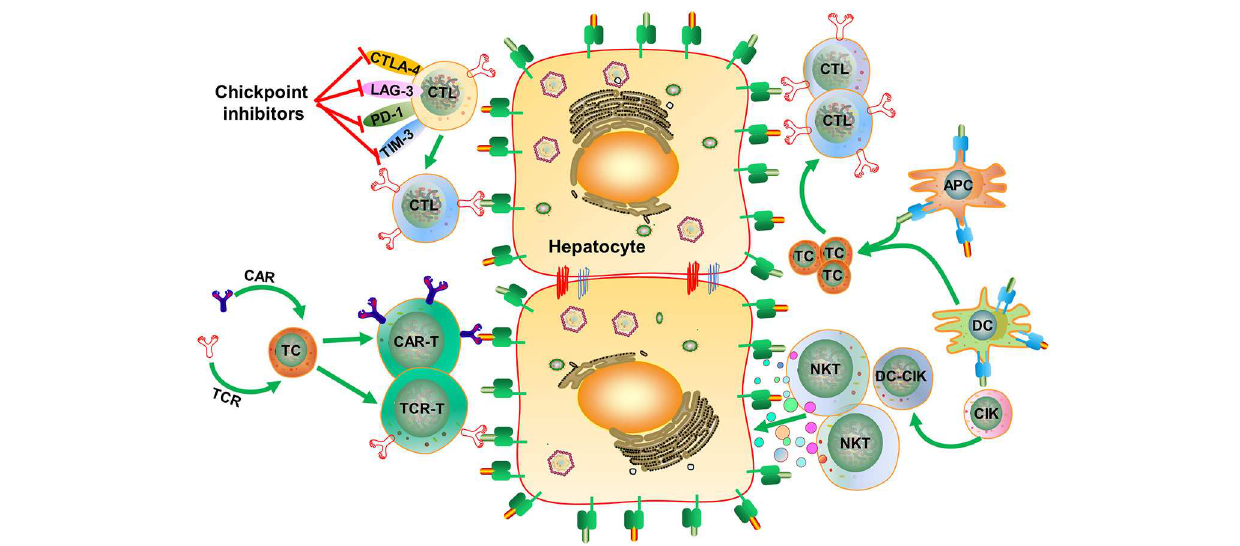
FIGURE 3 | Strategies for inducing HBV-specific immune responses and regaining immunological control of HBV infection. HBV-specific CD8 + T cell responses can be induced by therapeutic vaccines, boosted through checkpoint blockade, or renewed by adoptive transfer of in vitro activated T/NKT cells or genetically edited HBV-specific CAR-T or TCR-T cells. CTLA-4, cytotoxic T-lymphocyte-associated protein 4; LAG-3, lymphocyte activation gene-3; PD-1, programmed death-1; TIM-3, T-cell immunoglobulin and mucin-domain containing-3; APC, antigen-presenting cell; DC, dendritic cell; CIK, cytokine-induced killer; CAR-T, chimeric antigen receptor T-cell; TCR, T cell receptor. Dots in various colors indicate different cytokines; , Hepatitis B surface antigen/epitopes; Hepatitis B core antigen/epitopes; , Major Histocompatibility Complex class I molecule; , Major Histocompatibility Complex class II